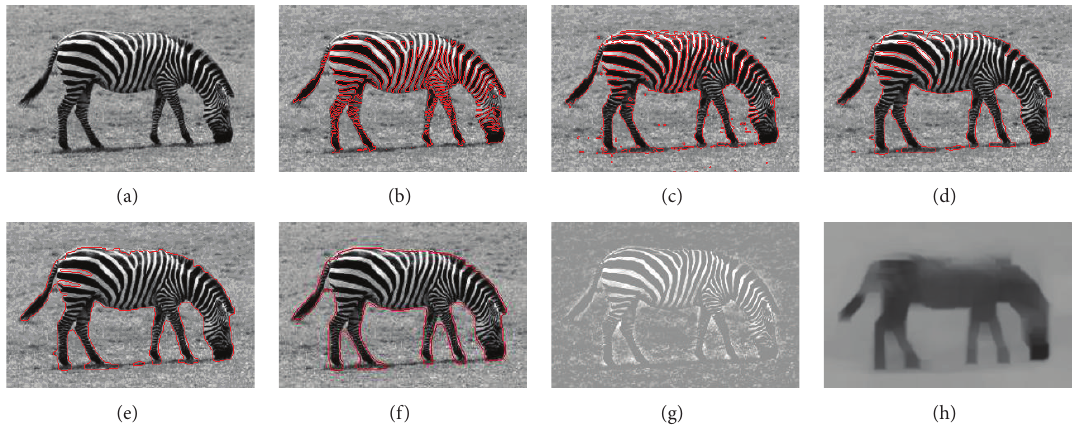
Figure 3: Image for segmentation: (a) original zebra image; (b) the intermediate result of step 20; (c) the intermediate result of step 40; (d) the intermediate result of step 60; (e) the intermediate result of step 80; (f) the final segmentation result; (g) the textural part of the zebra; (h) the structural part of zebra.